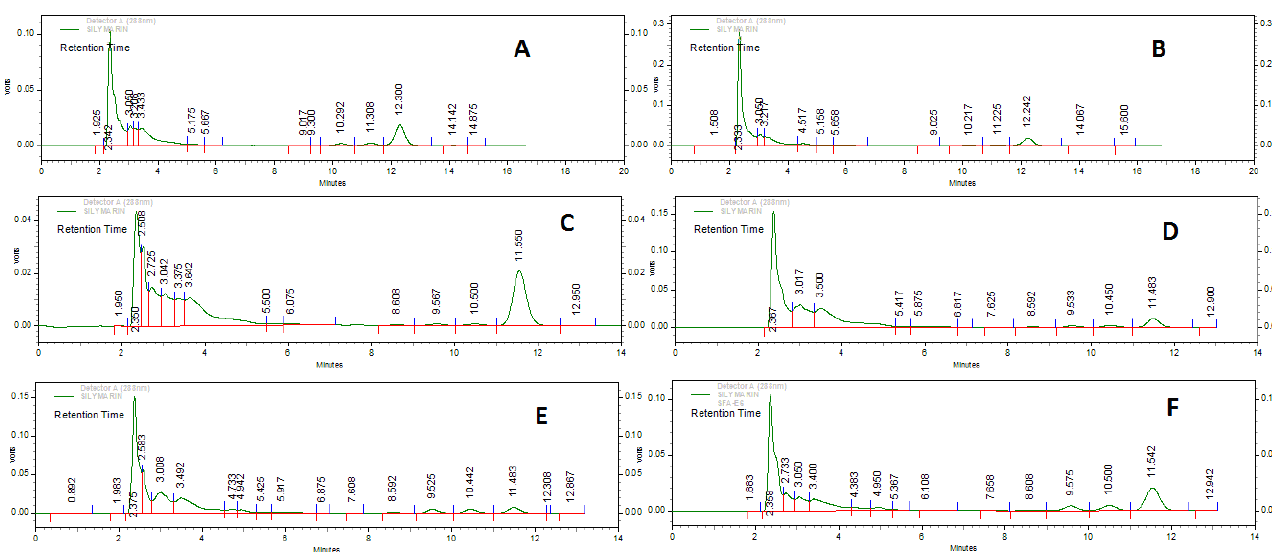
FIGURE 2 - Chromatograms of silymarin obtained for A) spiked plasma, B) plain silymarin (control), C) silymarin + lysergol, D) silymarin + piperine, E) silymarin + fulvic acid, and F) silymarin + fulvic acid + piperine